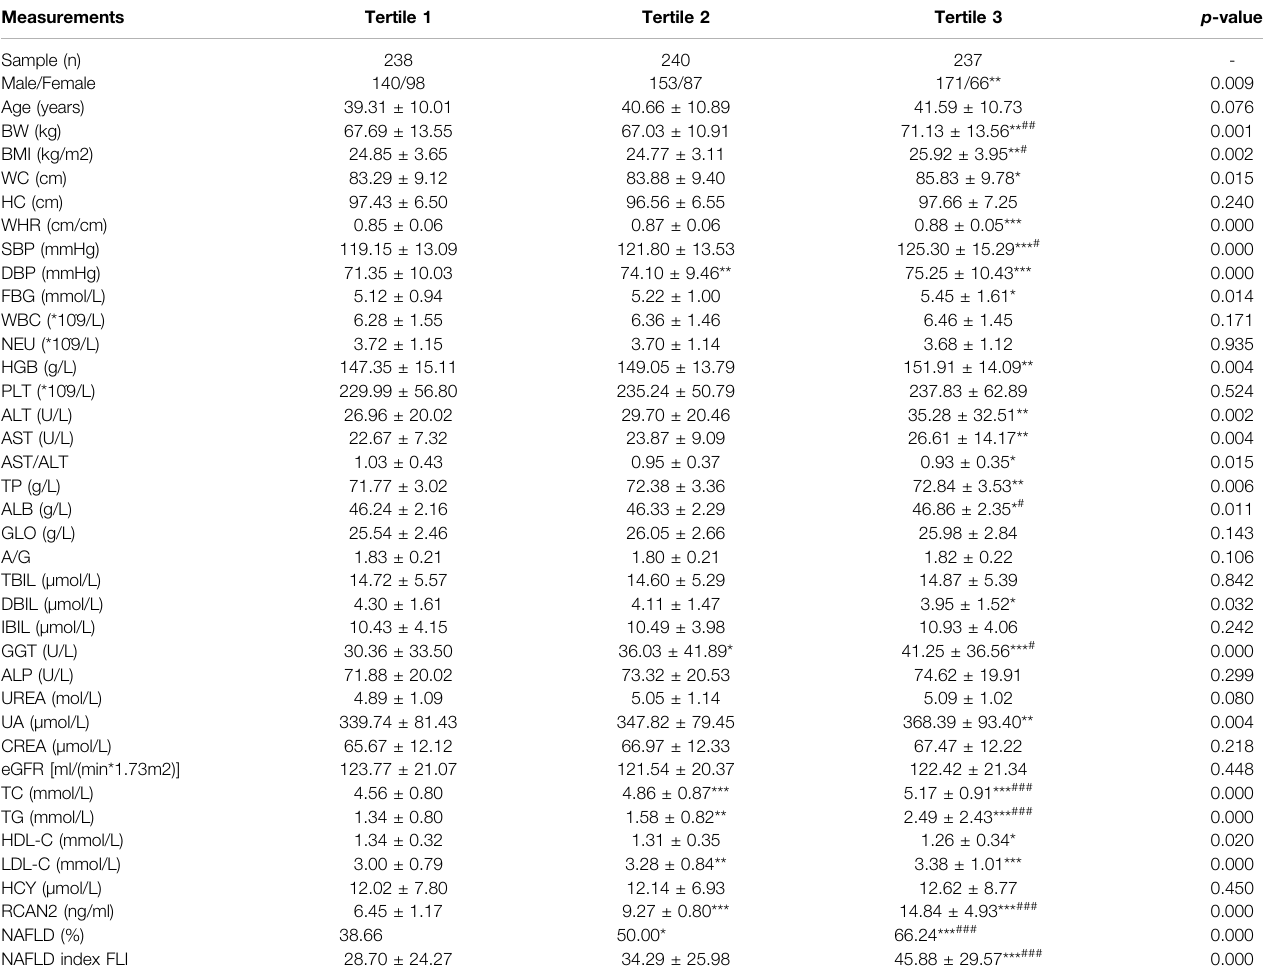
TABLE 2 | Clinical and biochemical characteristics by tertiles of serum RCAN2 level in all subjects. Measurements Tertile 1 Tertile 2 Sample